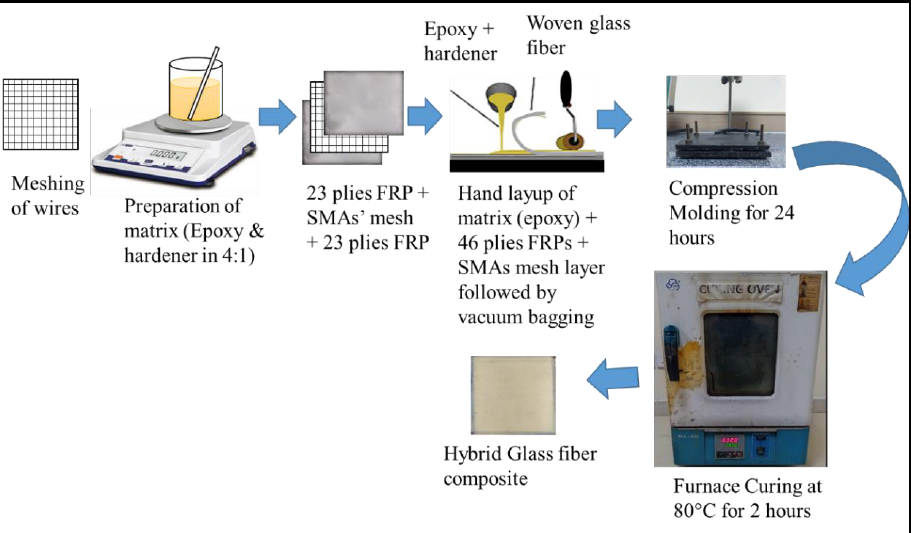
Figure 3. Schematic of experimental sequence for composite manufacturing.